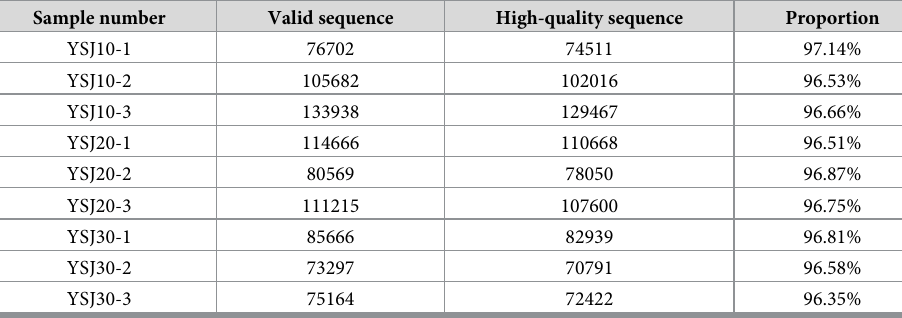
Table 1. 16S rRNA sequencing statistics for the YSJ